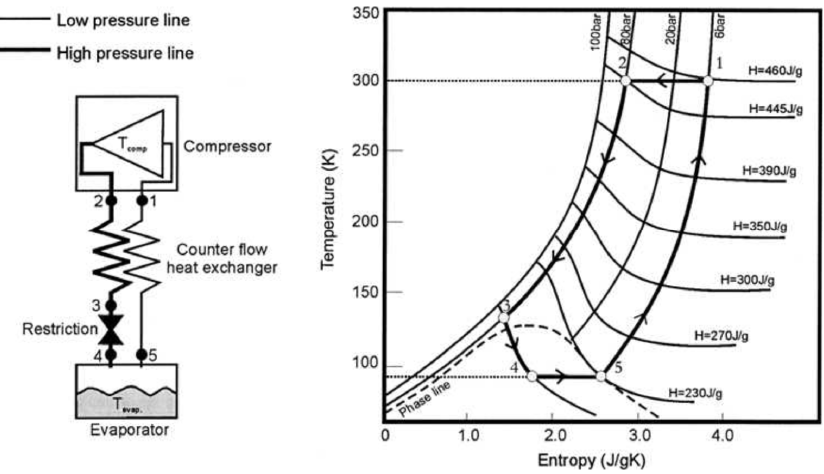
Figure 7. Hampson ‐ Linde cryogenic cooler functional diagram [17].